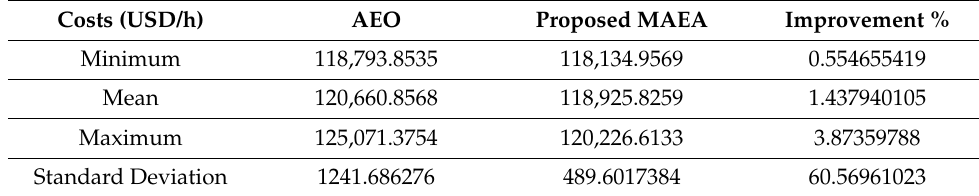
Figure 15. Percentage difference for the worst run and the average of all runs of the MAEA and AEA of Case 4. 5. Conclusions In this paper, a promising solution methodology based on a novel Modified Artificial Ecosystem Algorithm (MAEA) with superior performance and significant convergence has been proposed for solving the Economic Dispatch (ED) with Combined Heat and Power Units (CHPUs). The proposed MAEA combines the original AEA with a Fitness Distance Balance Model (FDBM) to increase solution quality in non-linear and multivari- ate optimization contexts. The FDBM was used as a method of selecting individuals which will contribute the most to the seeking paths within a community in a dependable and productive manner. As a result, the processes of diversification and intensification were carried out in a balanced manner. Both algorithms have been carried out in comparison